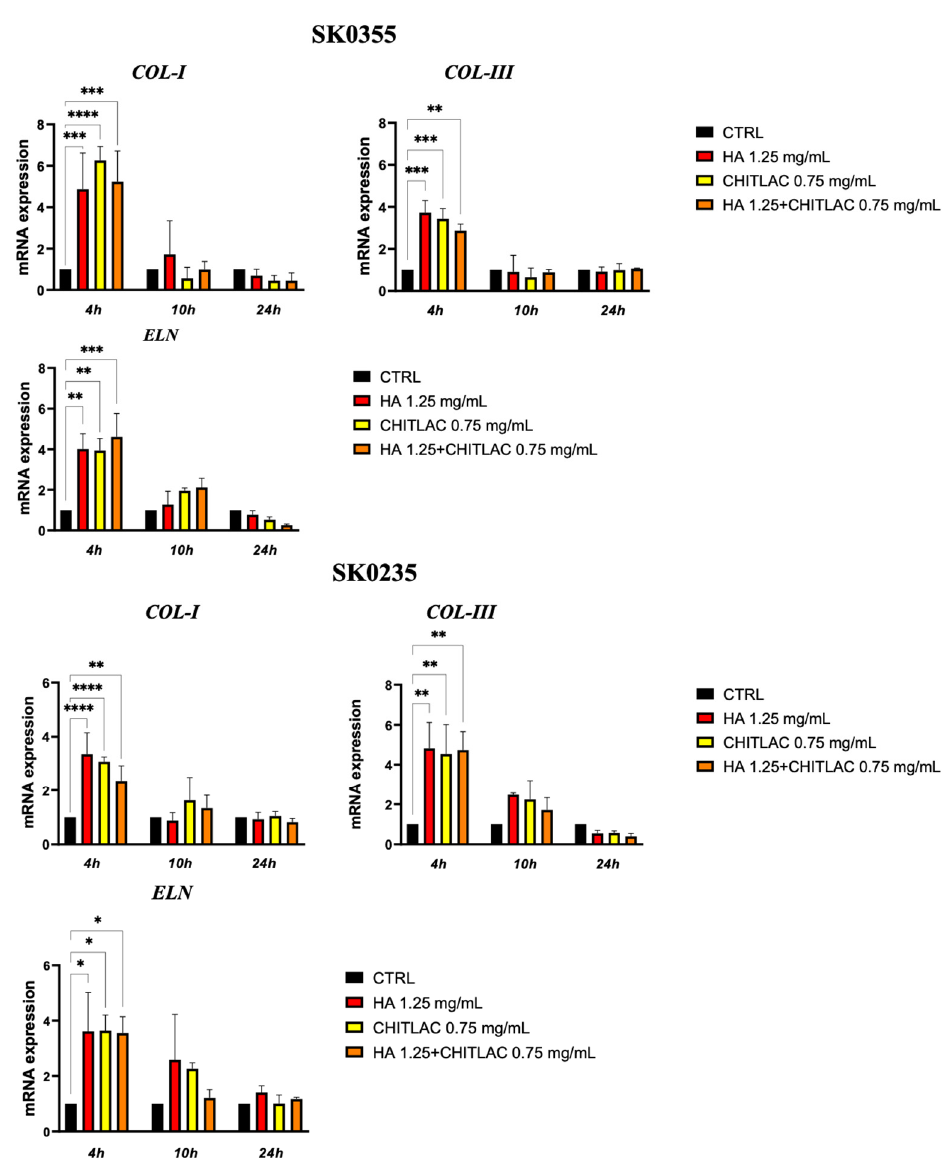
Figure 5. Dermal fibroblast gene expression of ECM molecules in the presence or absence of HA, CTL and HA-CTL mixture. Human dermal fibroblasts SK0355 (from a 30-year-old woman) and SK0235 (from a 54-year-old woman) were seeded in 6-well culture dishes and cultured in the presence or absence of 1.25 mg/mL HA, 0.75 mg/mL CTL or their mixture. RNA transcript levels specific for COL-I, COL-III and ELN were evaluated by qPCR as described in the Materials and Methods section at 4, 10 and 24 h after treatment. Statistical differences are based on one-way ANOVA test with multiple comparisons. Data are expressed as mean ± SE obtained from three independent experiments. * p < 0.05, ** p < 0.01, *** p < 0.001 and **** p < 0.0001 vs. respective control.